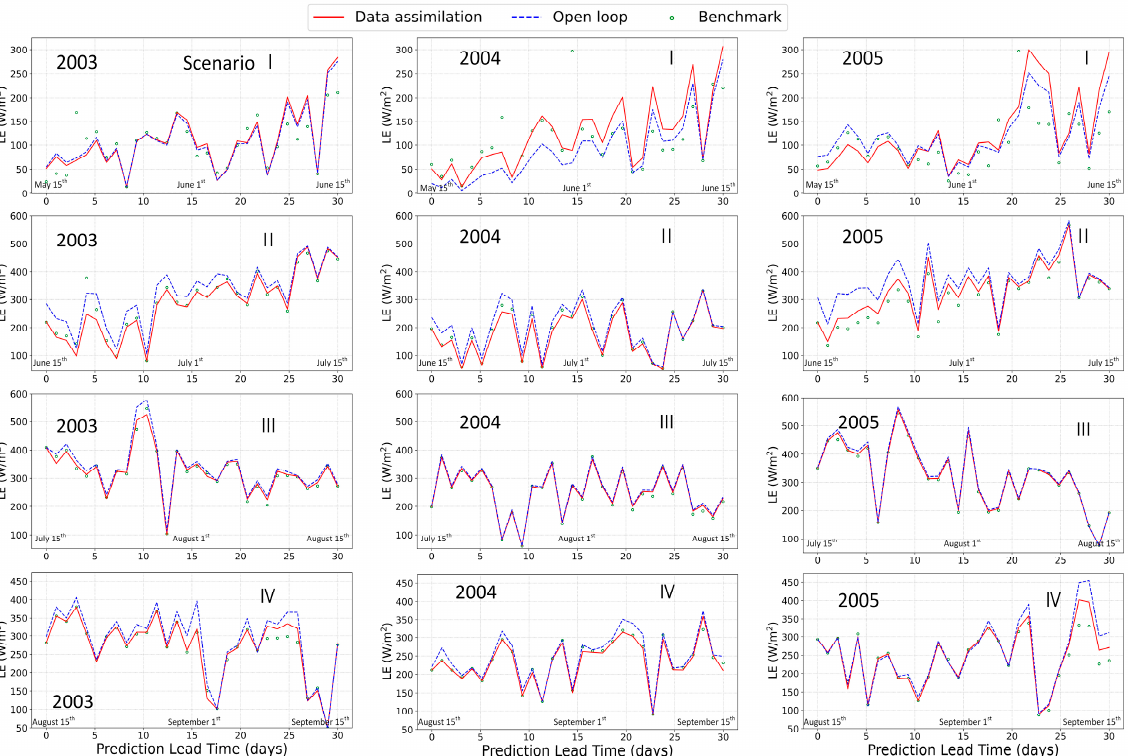
Figure 5. Latent heat flux predictions from OL and MLDAS in 2003–2005. Predictions of four assimilation scenarios are given. Columns represent different assimilation scenarios in each year. The red solid line in each subplot represents MLDAS prediction in one future month; the blue dashed line in each subplot represents OL simulation; and the green hollow scatters represent LE benchmarks.